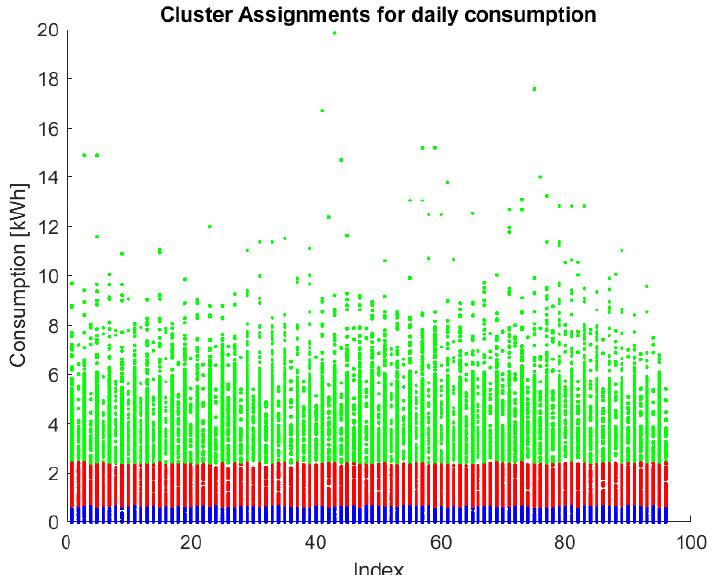
Figure 6. Representation of the 3 clusters in which the daily consumption data, recorded every 15 min from the Faculty of Building Services, was grouped. Green — the cluster of the high-value con- sumption data, red — the cluster of the medium-value consumption data, and blue — the cluster of the low-value consumption data.